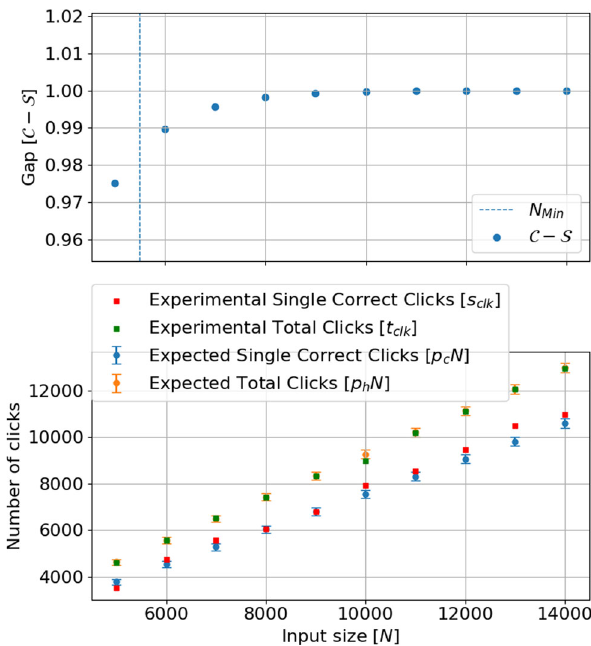
Fig. 4 Experimental data. (Top) Plot of the gap as a function of N when simulating the protocol with the nominal parameters of ν N = 0.93, μ N = 1.31 and δ = 0.15. The vertical line bounds the region for quantum advantage. (Bottom) Number of clicks as a function of N . The correct bits are clicks in the correct detector or in both detectors with half probability and total clicks is the total number of measured pulses. Each square corresponds to one run of the protocol whereas the dots with error bars are numerical. Because each pulse gives a poissonian probability distribution in the ffiffiffiffiffiffiffiffiffiffiffiffiffiffi p # clks number of photons, the error bar is given by 2 which is twice the root mean square of the poissonian. Table 1 Summary of experimental data. In each run we increase the input size N by 1000. The table shows: the actual visibility in each run; the average number of photons per pulse; the number of measured single clicks and those that were in the correct detector; number of double clicks, which correspond to randomly assigned variables; the missing bits to complete the solution; the threshold of correct measured clauses for accepting a proof; the number of satis fi ed clauses in the experiment. The parameters δ = 0.15, ν N = 0.93, and μ N = 1.31 are kept fi xed in the theoretical analysis of the